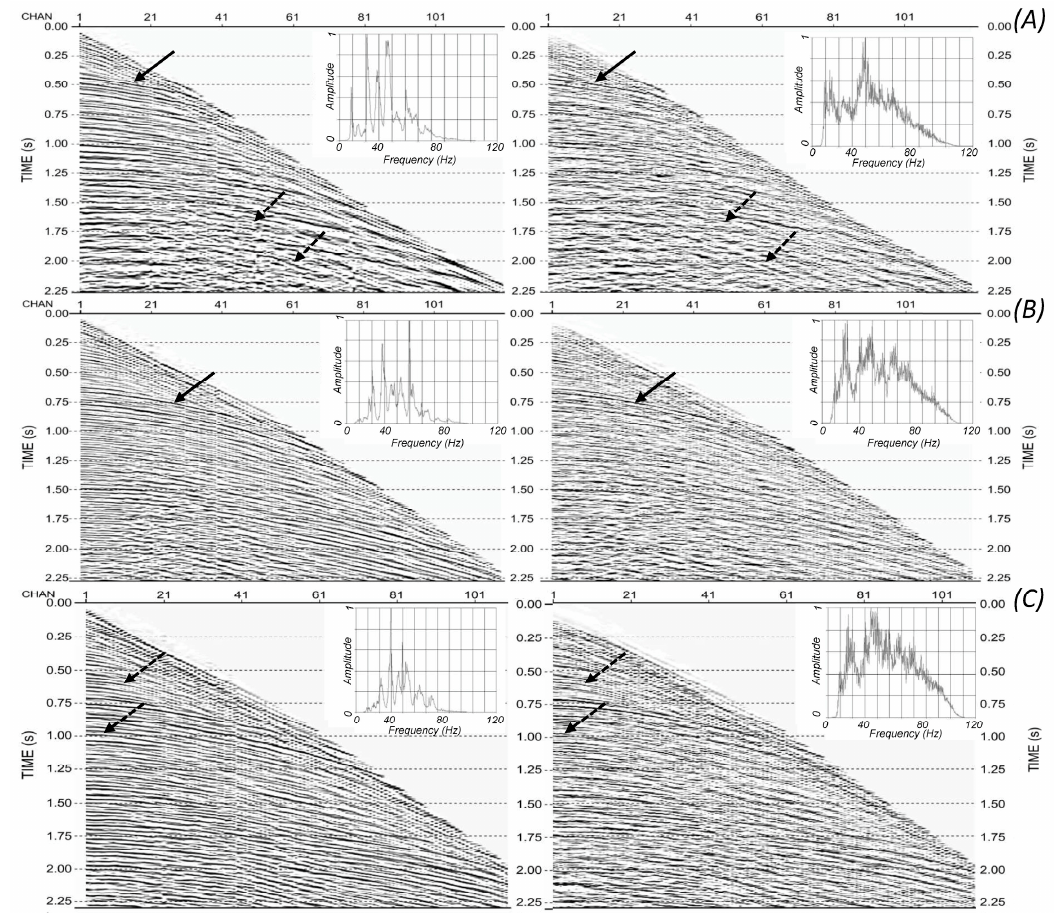
Figure 1. An example of three shot gathers and their amplitude spectra (insets) (panel ( A – C )) before (left panels) and after WED (right panels) along the seismic lines. The black arrows indicate the main reflections, while the black dotted arrows indicate the attenuated noises as discussed in the text.